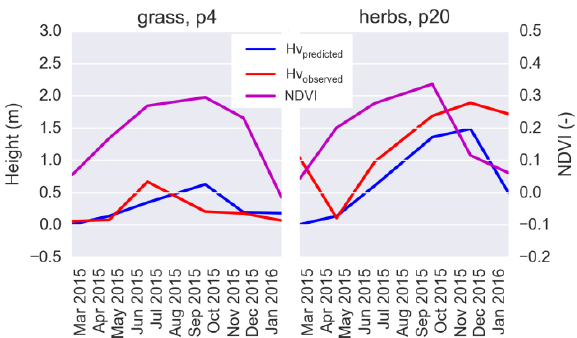
Figure 2. Time series of a grassland plot 4 and herbaceous plot 20 indicated on the orthophoto in figure 1.